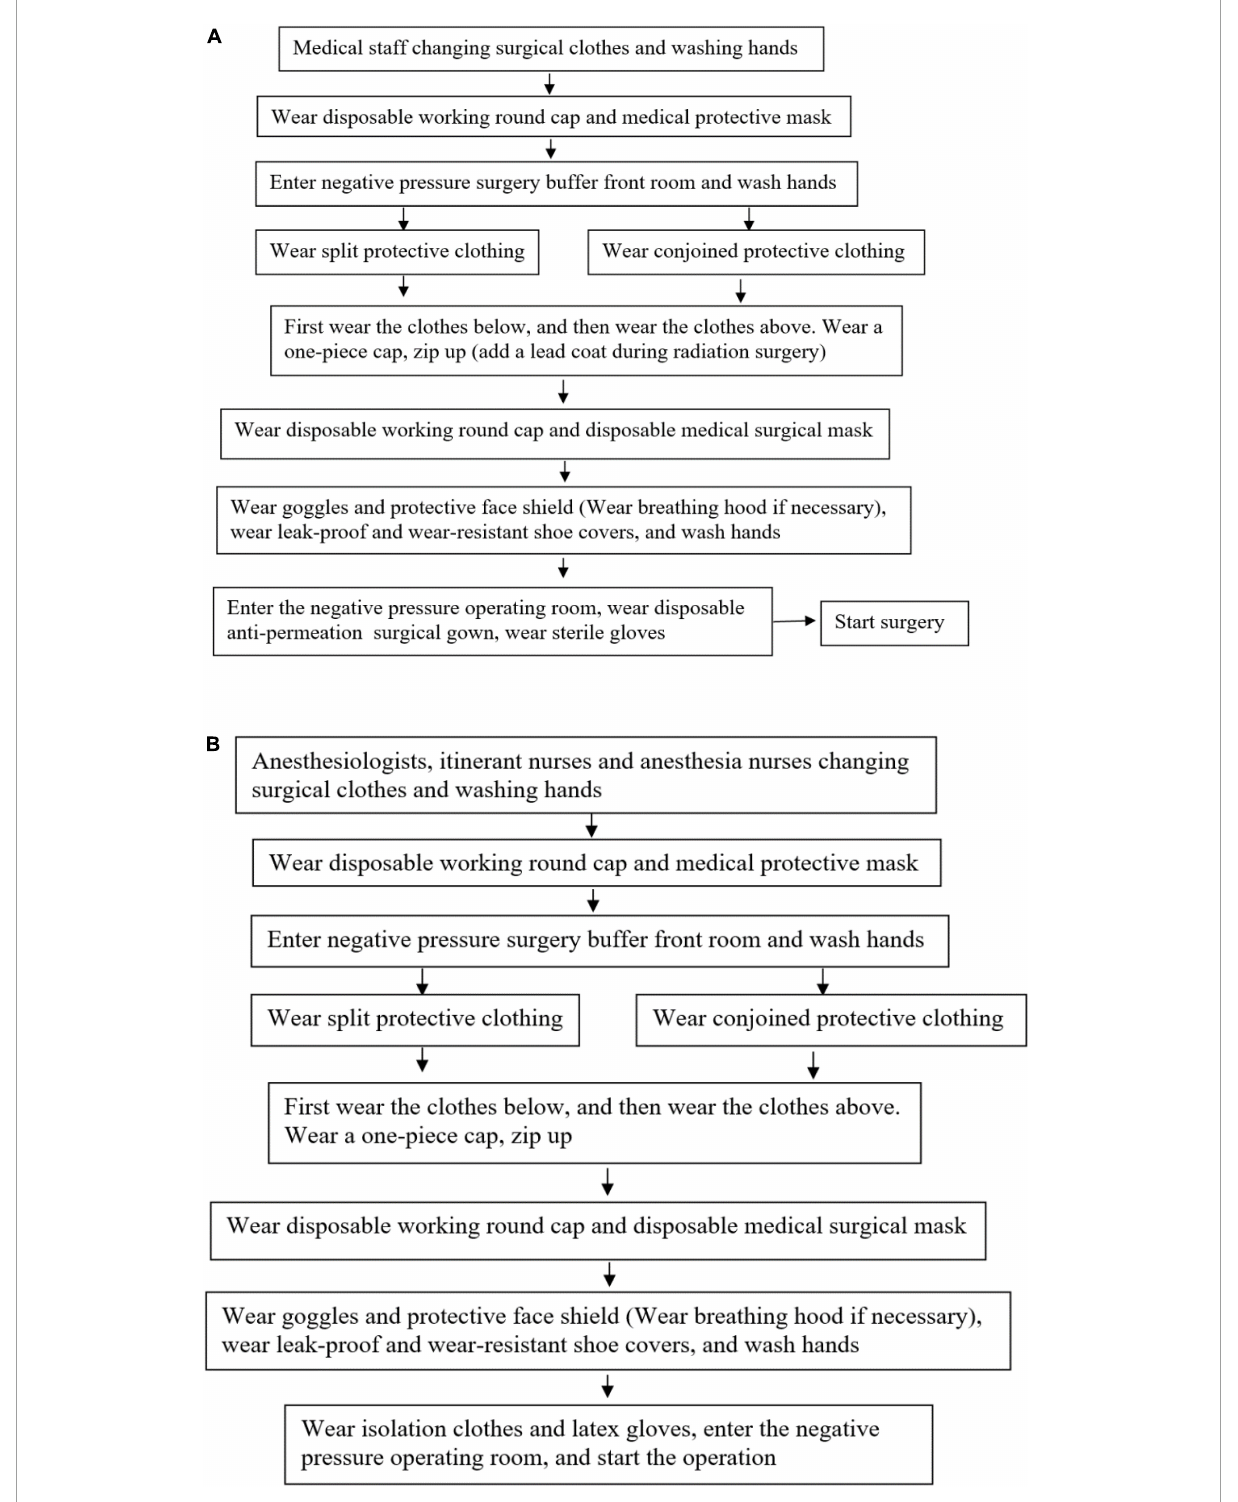
FIGURE1 (A) Process of putting on medical protective articles for surgeons and instrument nurses in surgical operations on patients with confirmed or suspected SARS-CoV-2. (B) Process of putting on medical protective articles for the anesthesiologist, circuit nurse, and anesthetic nurse in surgical operations on patients with confirmed or suspected